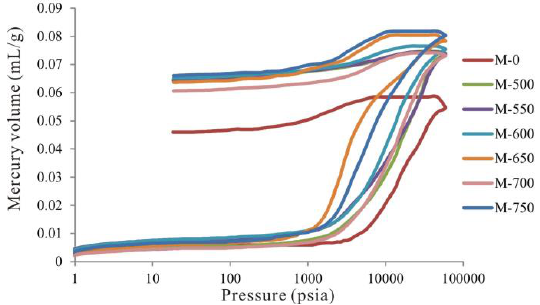
Figure 8. Mercury injection and ejection curves of the shale samples, derived from mercury intrusion.